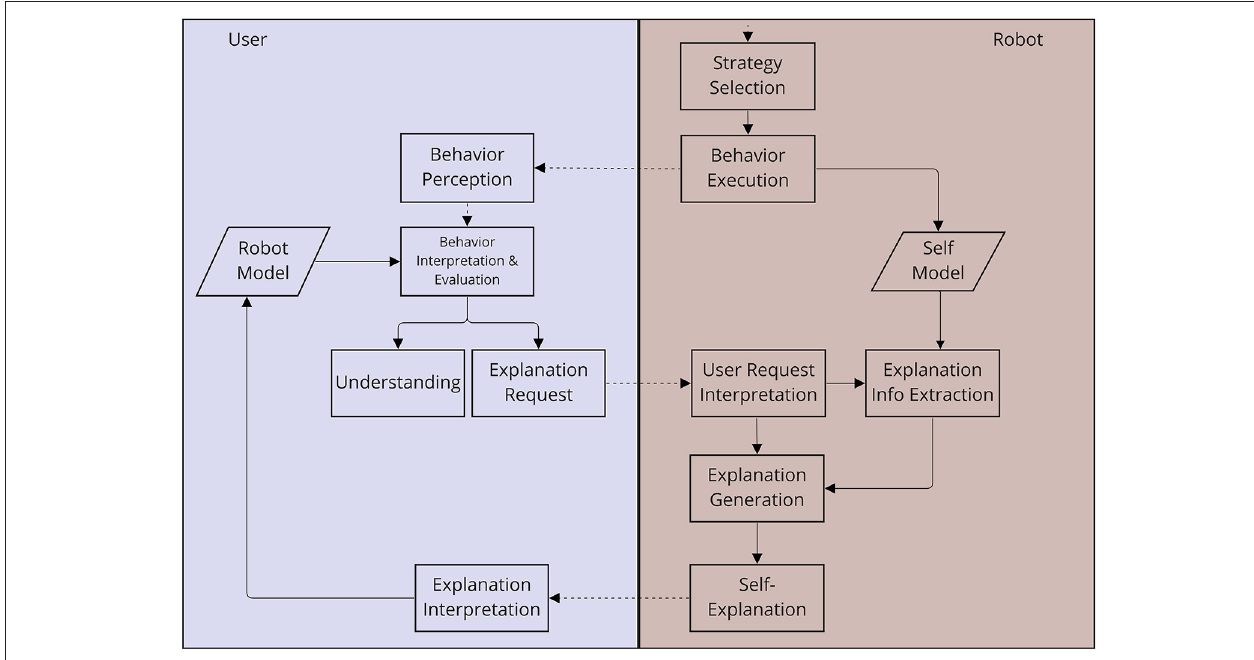
FIGURE 2 | Overview of the proposed framework for robot self-explanations in social human-robot interaction.